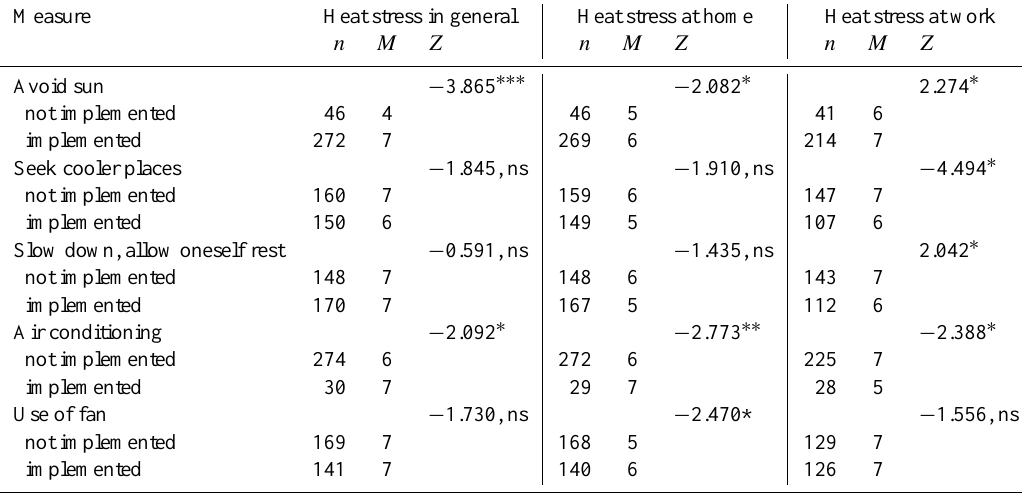
Table 4. Differences in subjective heat stress by implemented measures. Measure Heat stress in general Heat stress at home Heat stress at work n